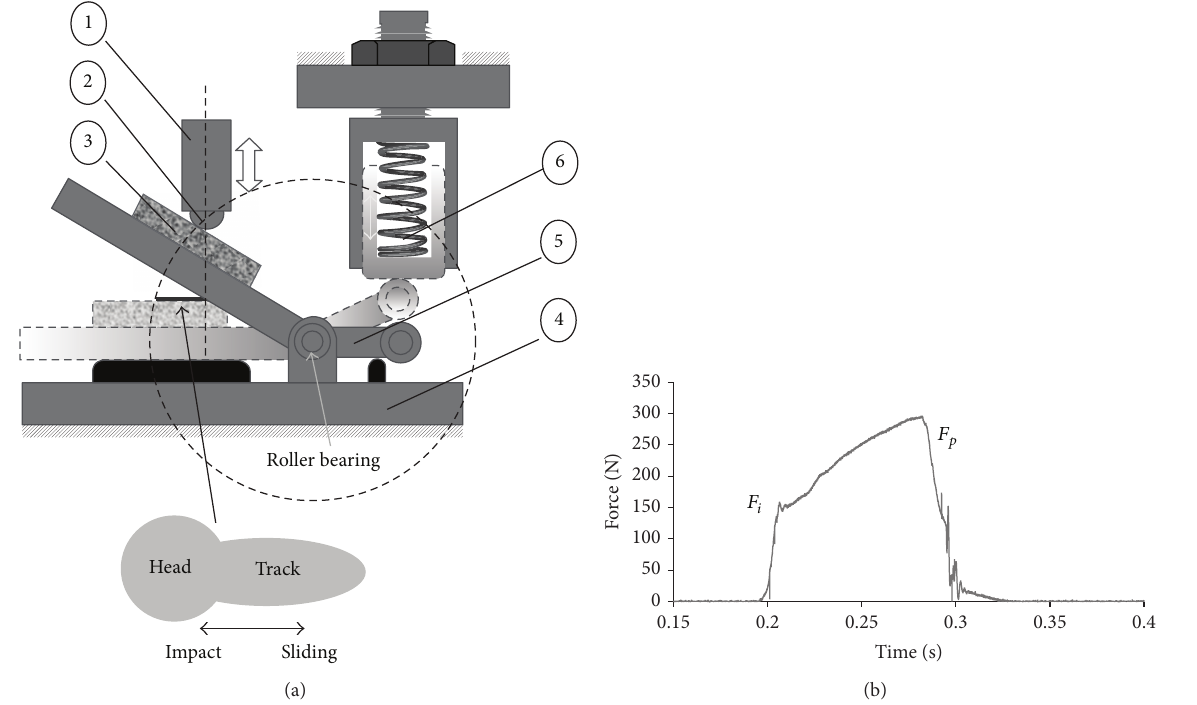
Figure 2: Impact sliding test method [14]. (a) Diagram of the impact sliding test method with labelled components, where 1 is ball specimen drive (e.g., air cylinder), 2 is ball specimen, 3 is flat specimen (i.e., coating), 4 is rigid frame, 5 is rotatable rocker, and 6 is return drive (e.g., spring). (b) Load versus time graph of surface undergoing the impact sliding test method.